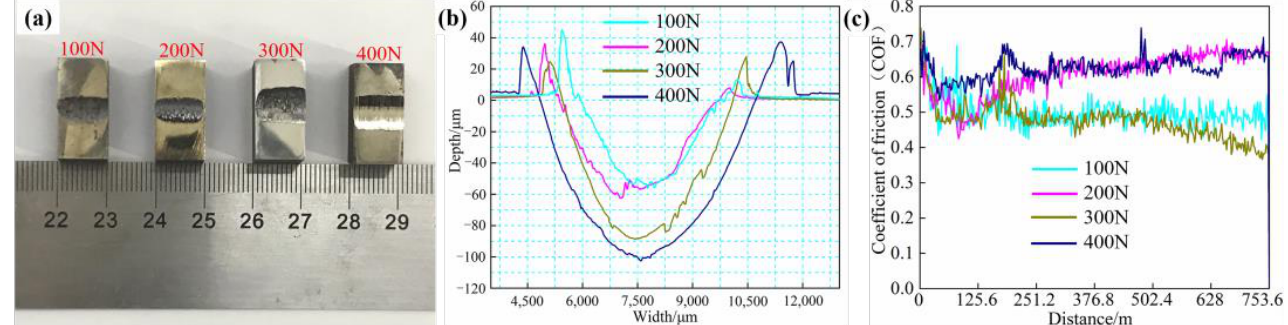
Figure 7. Different loads under 500 °C: ( a ) surface of FeCrSiNiCoC samples after wear test; ( b ) measurements of typical wear surface morphology using sample wear-track sections; and ( c ) COF distance curves of samples. Table 4. Wear width, wear depth and wear rate of coatings at various loads.